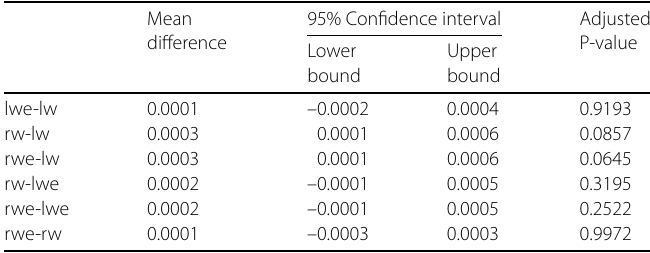
Table 21 Multi-group mean comparisons of purity using Tukey’s HSD test Mean 95% Confidence interval Adjusted difference P-valueLower Upper bound bound lwe-lw